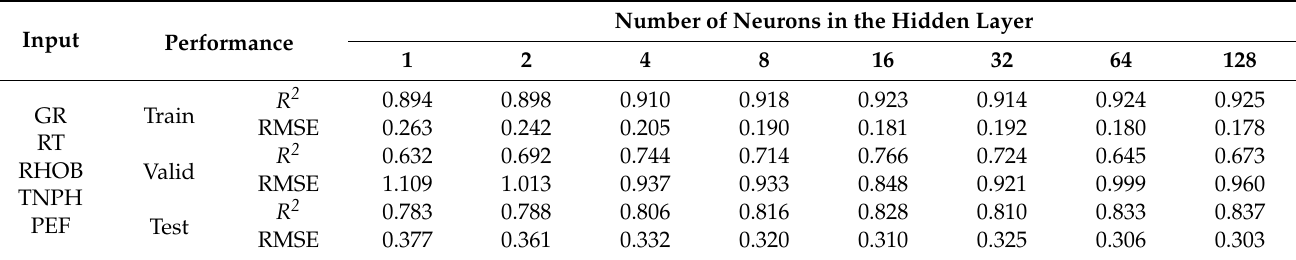
Table A5. Performance for generating synthetic Vp using five input